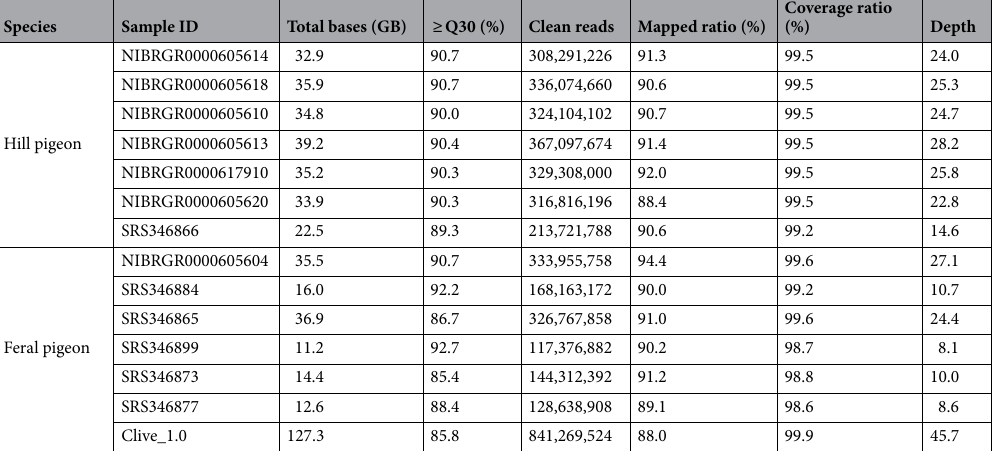
Table 1. Summary of the original sequencing data of seven hill pigeons and seven feral/domestic